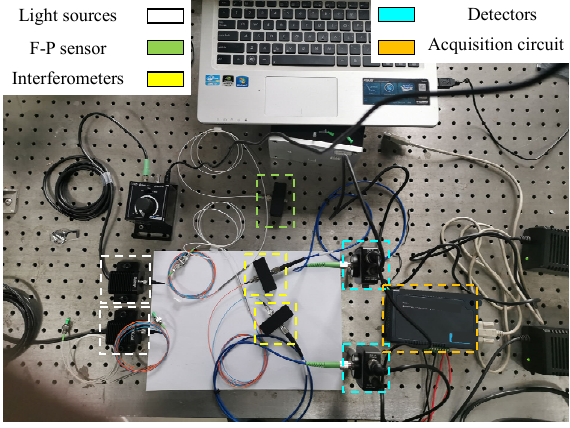
Fig. 11 Physical connection diagram of demodulation system. Table 1 Experimental results of interferometer